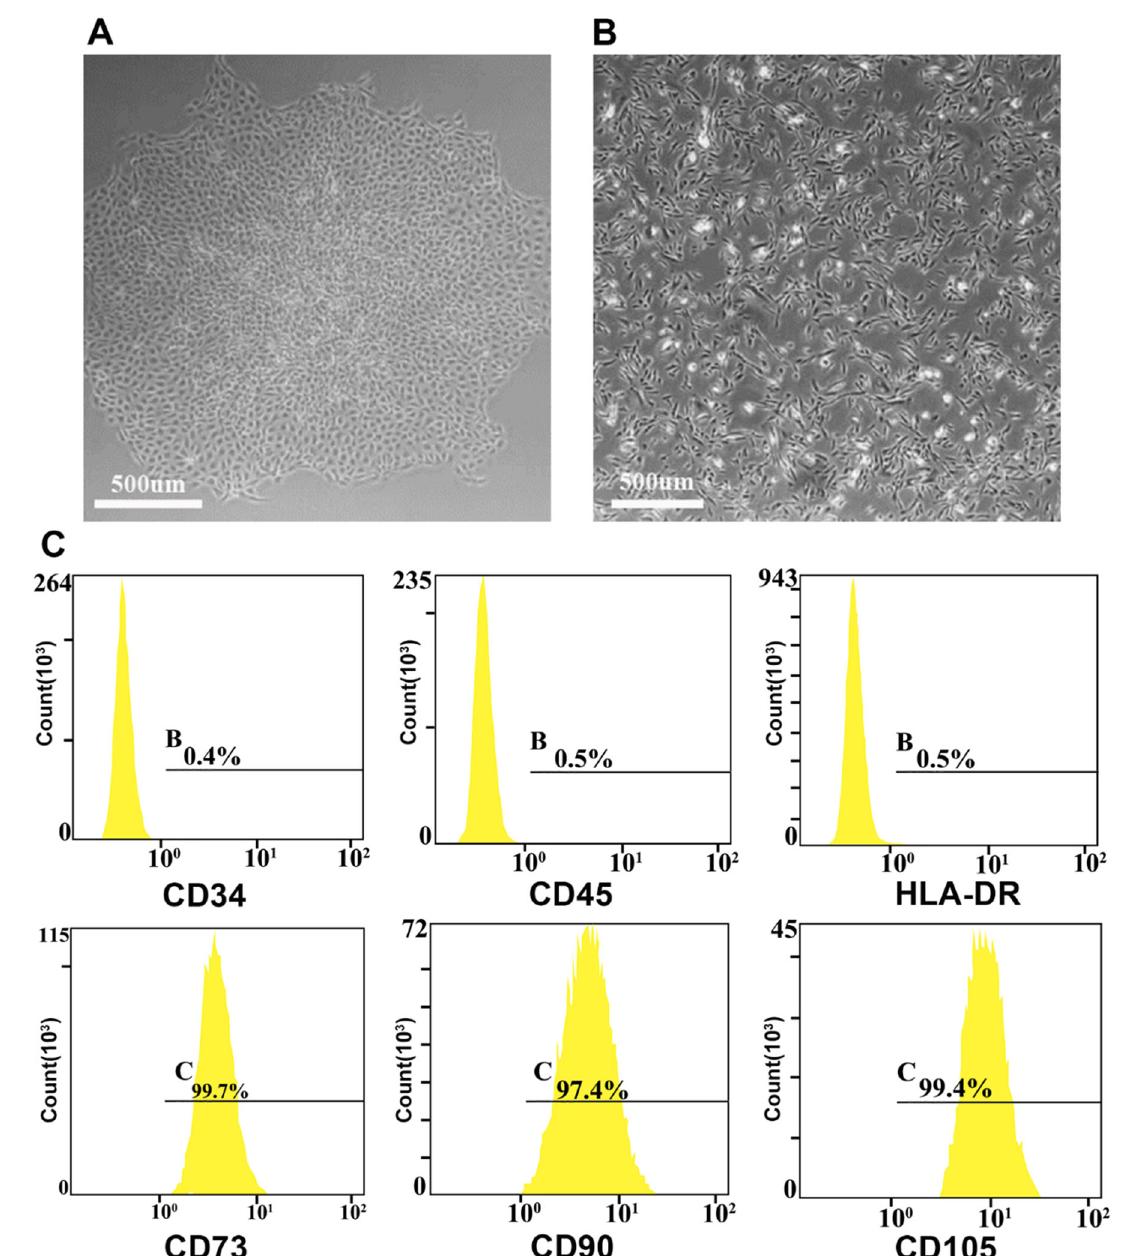
Fig. 1 USCs were identi fi ed by microscopy and fl ow cytometry. A Morphology of primary USCs cultured for 2 weeks. B Morphology of fourth-generation USCs. C Flow cytometry results of negative